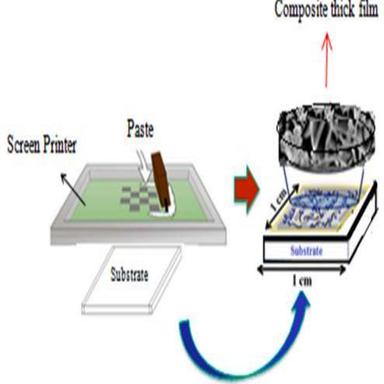
Schematic of(ZnO)0.90(CNT)0.10 thick film development via screen printing along with the inset of SEM image (ZnO)0.90(CNT)0.10 thick film.